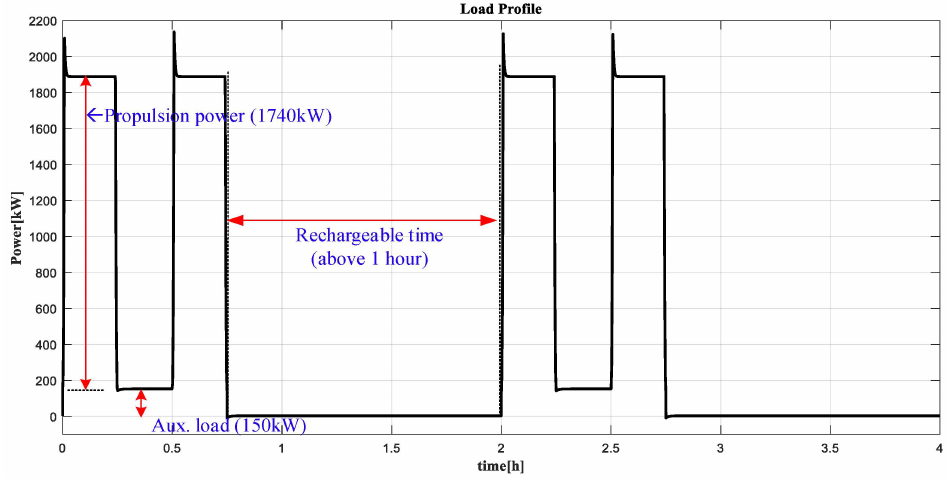
Figure 3. Load profile according to the operation profile.